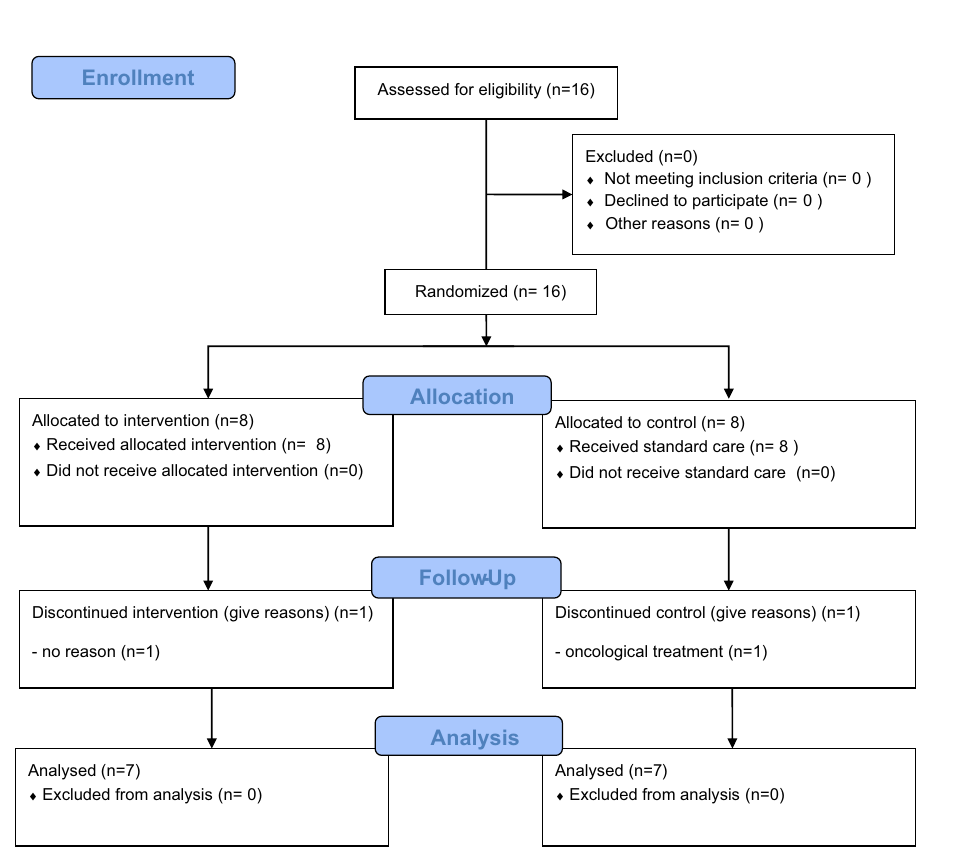
Figure 2. CONSORT flow chart (CONSORT, Consolidated Standards of Reporting